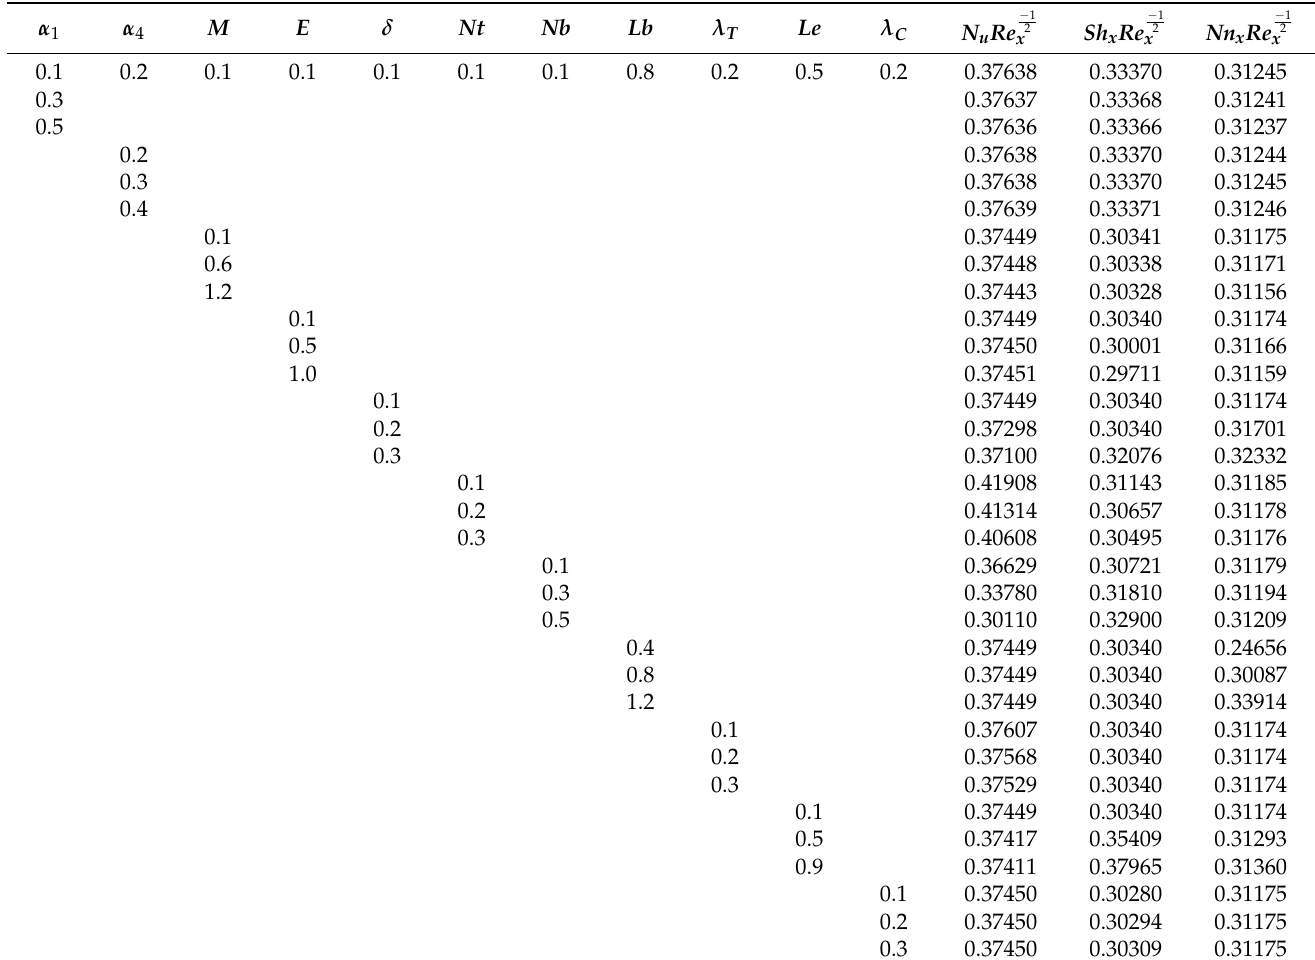
Table 2. Nusselt and Sherwood quantities and consistency amount at the stretching